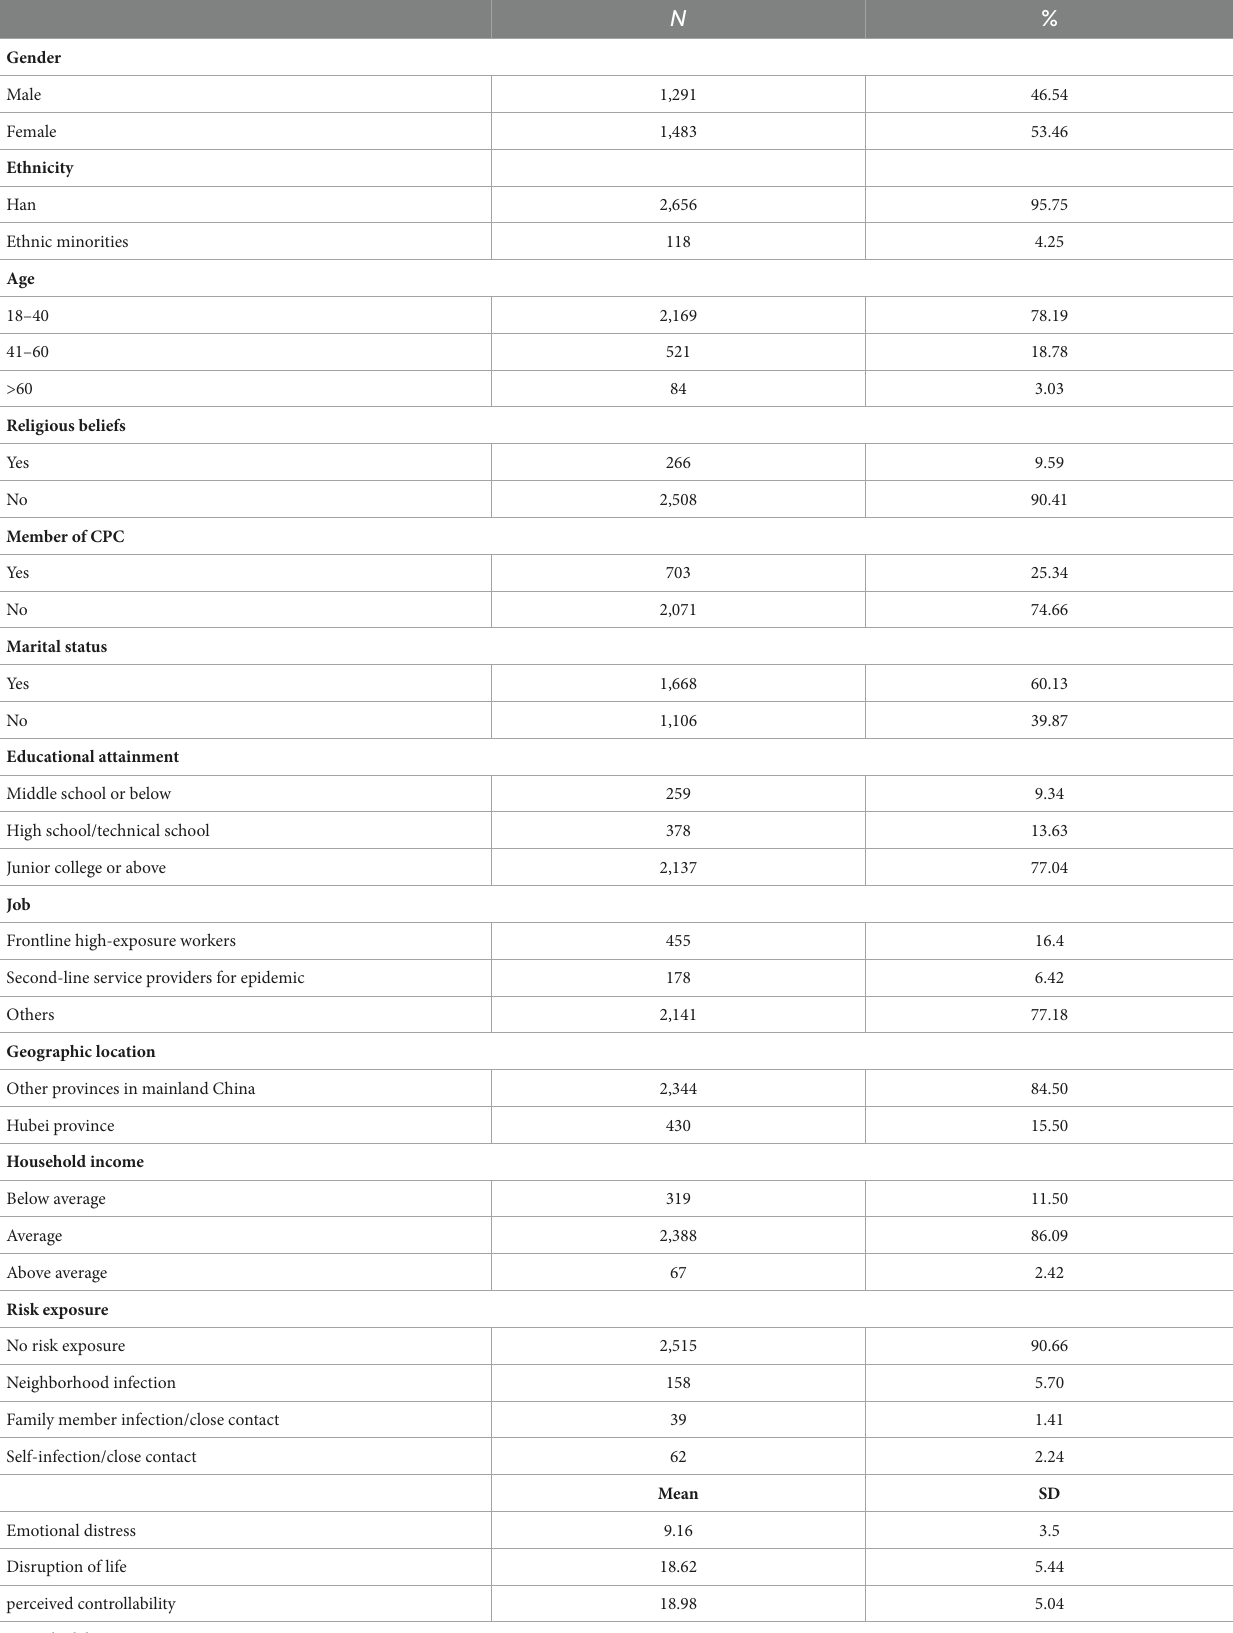
TABLE 1 Descriptive analysis of sample